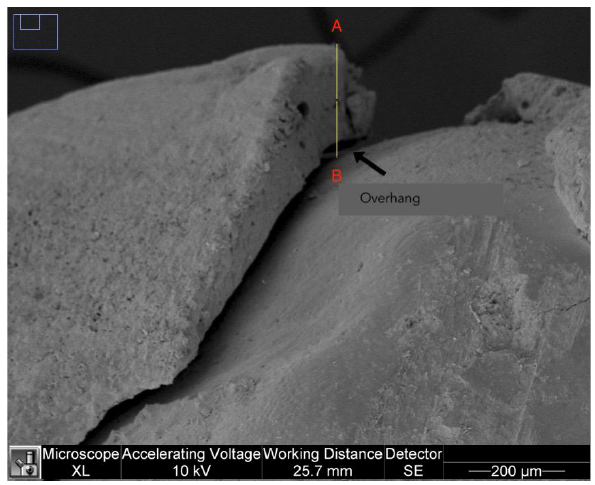
Figure 3. Overhang on a 250× image.